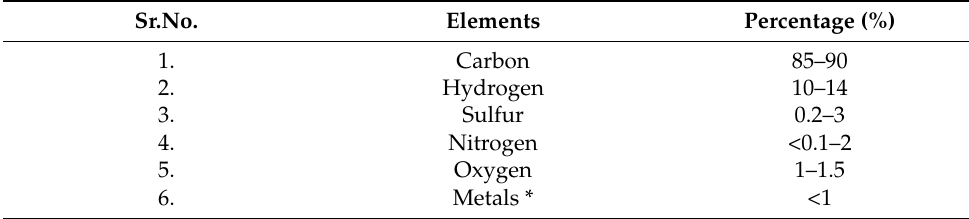
Table 1. Elemental composition of crude